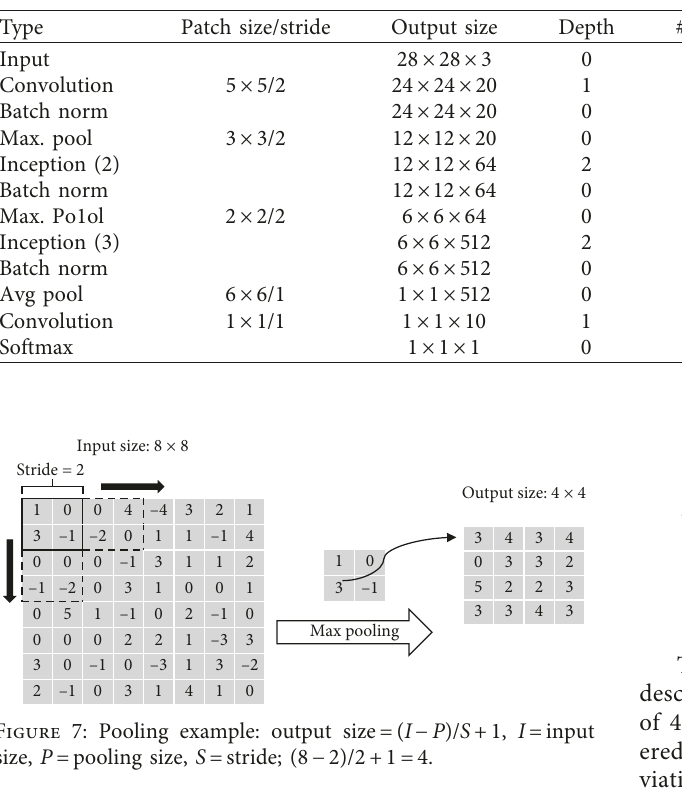
Table 2: Dimensions of layers and operations.